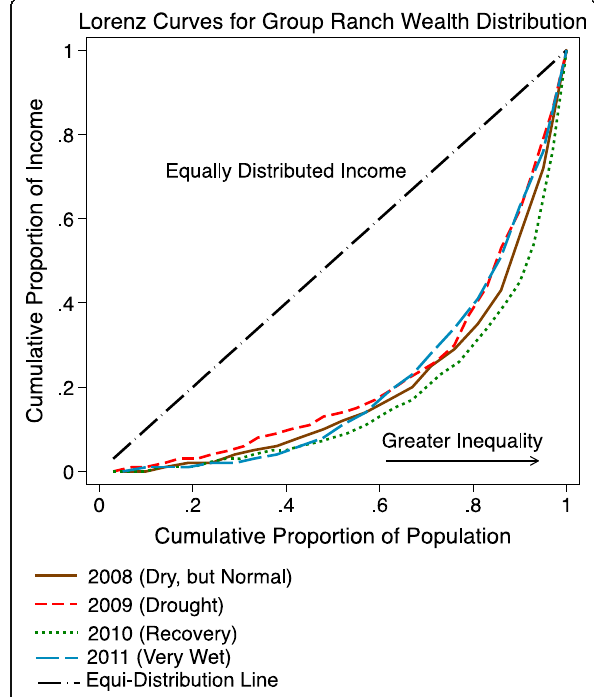
Figure 13 Lorenz curves of inequality plotted for each year of the current study against an income equi-distribution line. Income inequality is quite high in our system, with greater inequality present during good than bad rainfall years (2009 vs.